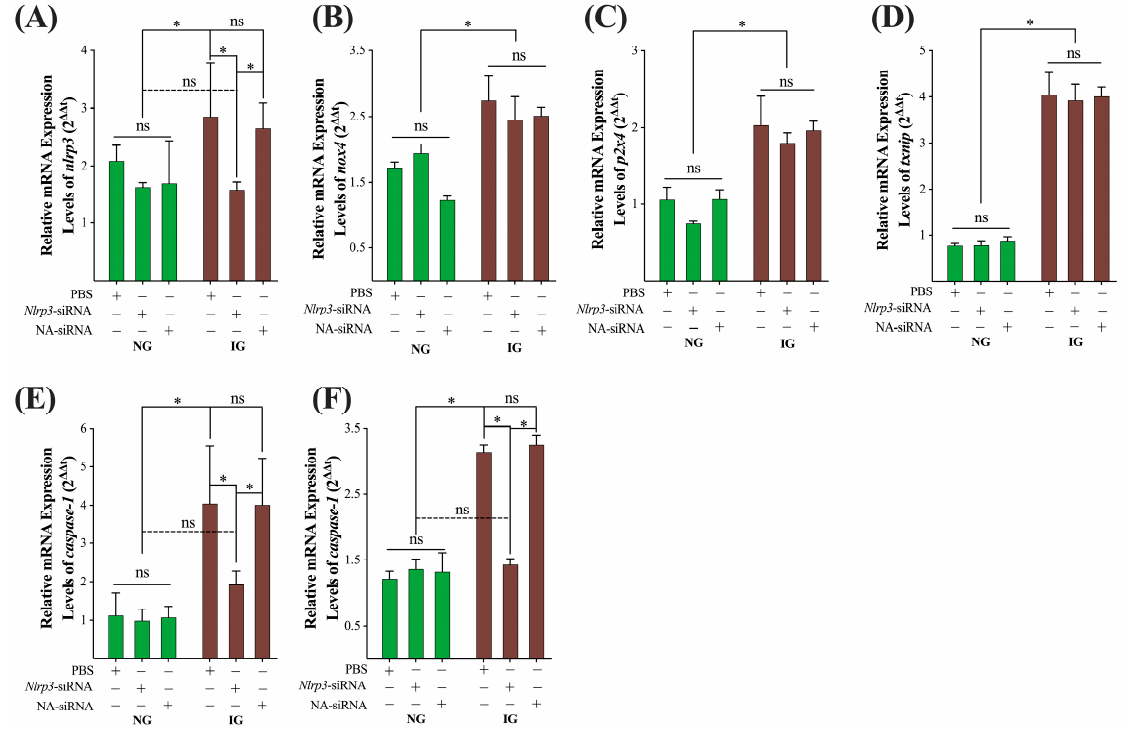
Figure 5. Knockdown of the nlrp3 gene inhibits the IG treatment-induced activation of the nlrp3 / caspase-1 / gsdmd pyroptosis pathway. ( A – F ) the relative mRNA expression levels of MDBK cells treated with siRNA targeting the nlrp3 gene and control siRNA. All experiments were repeated 3 times, and the data were presented using mean ± SD. Two-tailed t -test; * p < 0.05; ns,